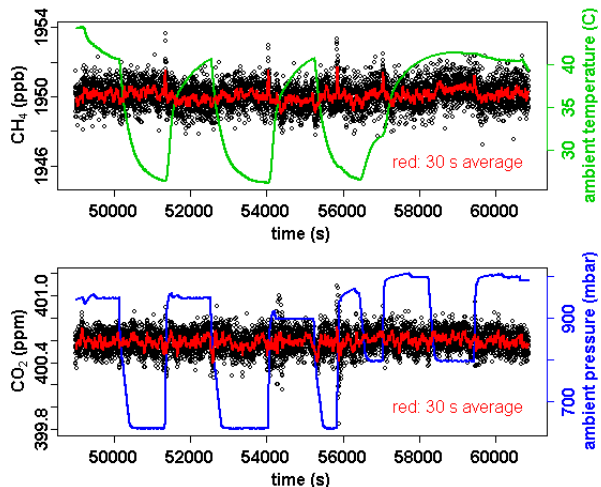
Fig. 3. CO 2 and CH 4 concentration measurements under simulated flight conditions. Variations of temperature and pressure are shown on the axis to the